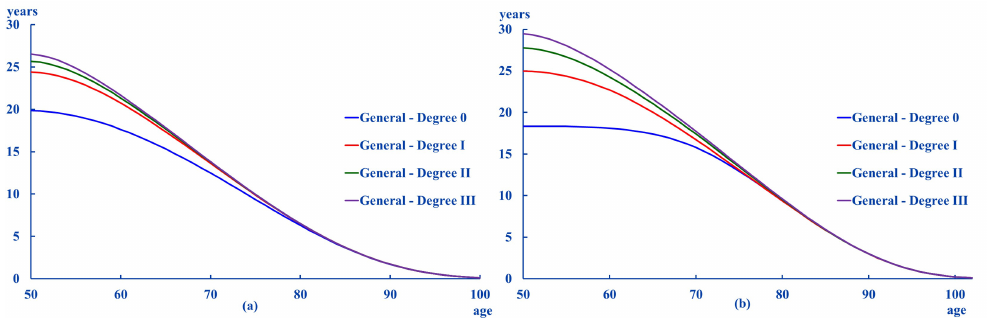
Figure 4. Differences in e x between general and dependent population. ( a ): men, ( b ): women Except for Degree 0, the differences between the two population groups are greater for women than for men. The figure suggests that there is an age beyond which this difference between the e x of the two populations does not depend on the intensity of dependency. This age is around 80 years for men and slightly earlier for